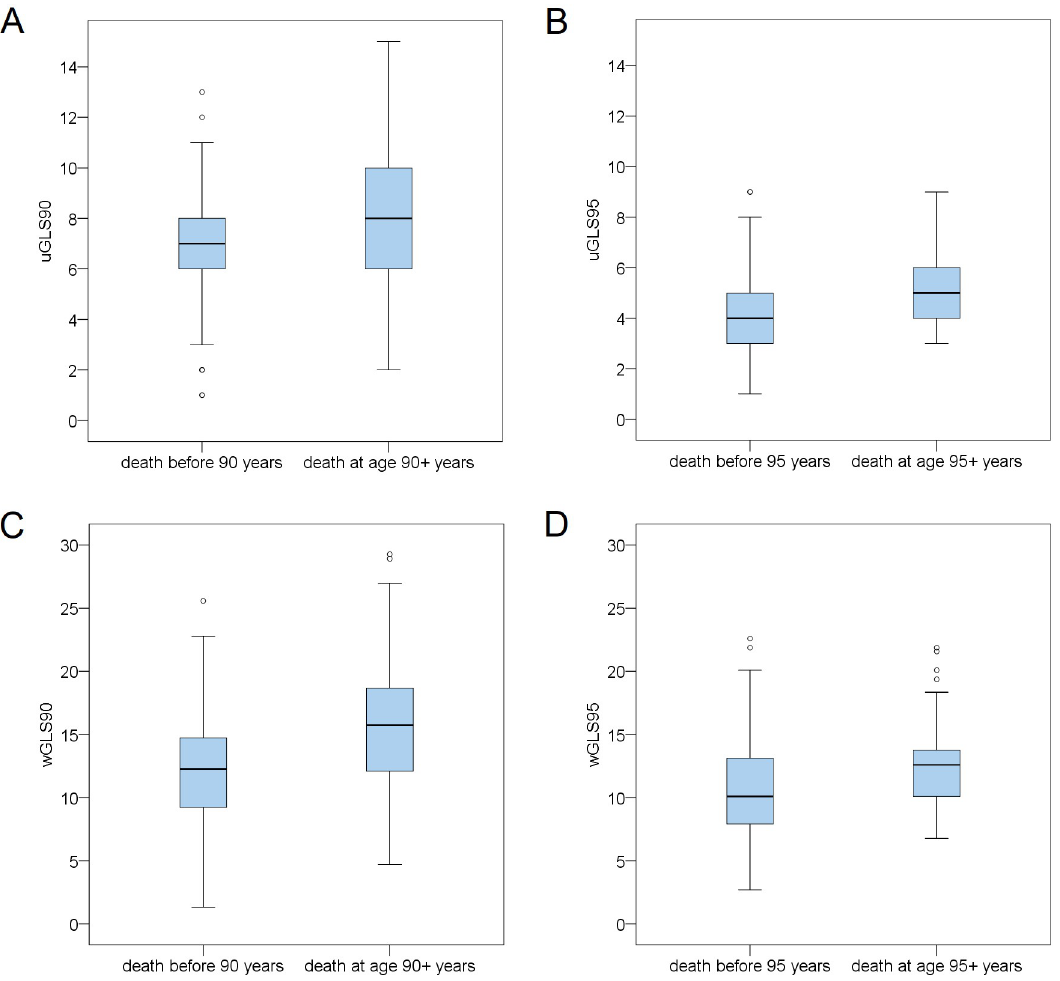
Fig 2. Comparison of the genetic longevity score values between participants who died before and after reaching the cut-off ages of 90 and 95 years. Box-and-whiskers plot showing the median value, quartile and extremes of A) uGLS90, B) uGLS95, C) wGLS90, D)